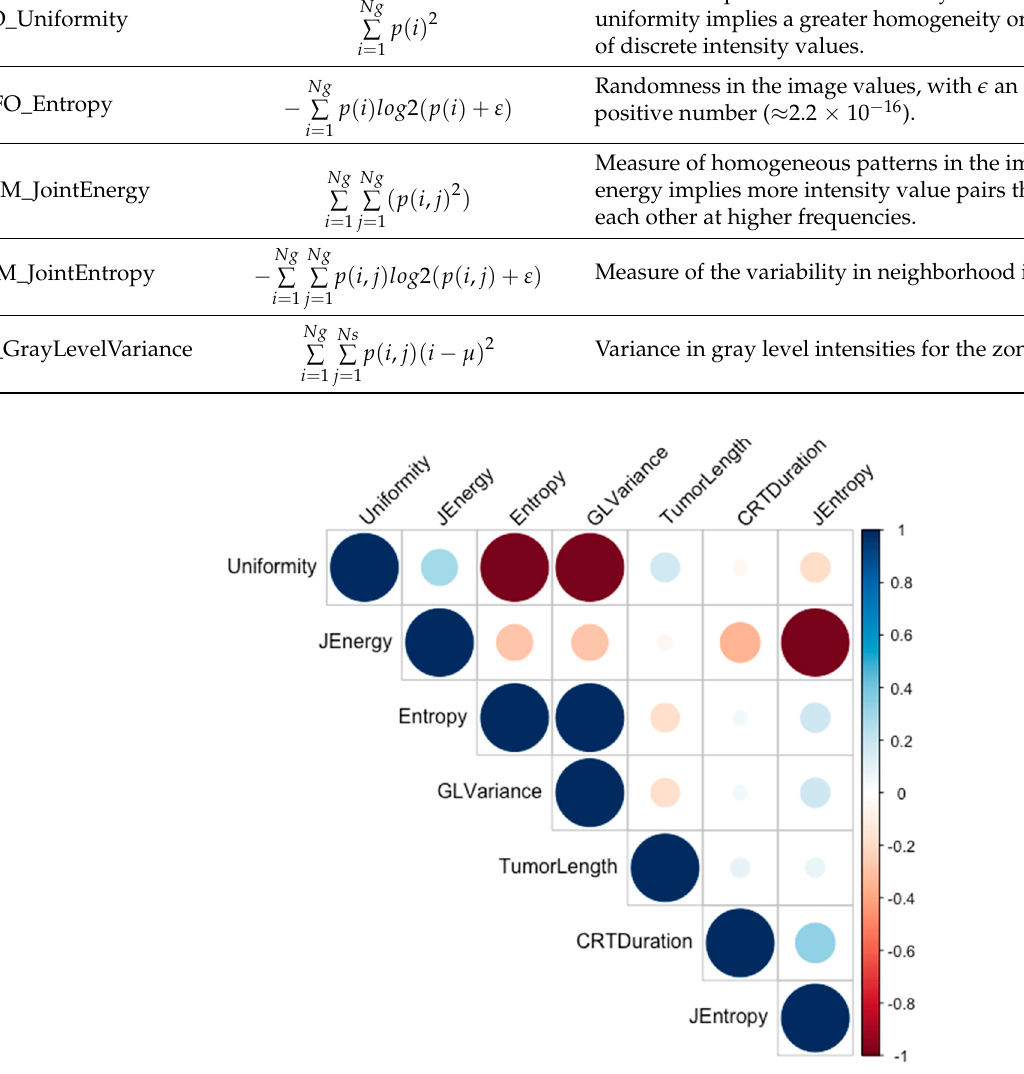
Figure 3. Correlation matrix between features significantly associated with the outcome in the training cohort. (Abbreviations: JEnergy = Glcm_JointEnergy, JEntropy = Glcm_JointEntropy, GLVariance = Glrlm_GrayLevelVariance, CRTDuration = Chemo-radiotherapy duration).